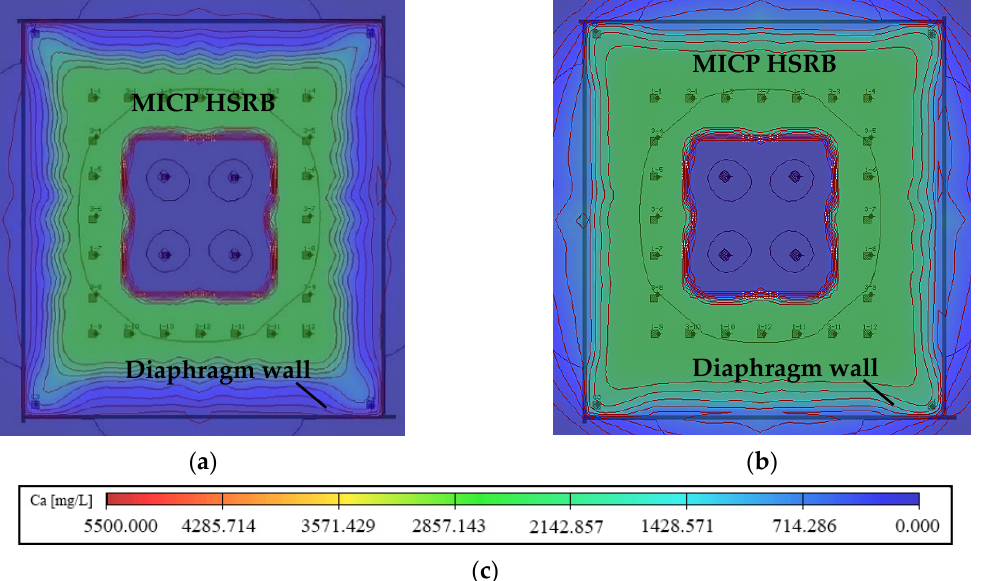
Figure 26. Horizontal migration diagram of stationary solution: ( a ) 400 m 3 /d; ( b ) 800 m 3 /d; ( c ) Leg- end.